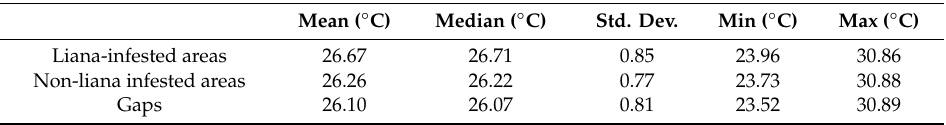
Table 1. Statistical characteristics of the canopy temperatures of the liana-infested areas, non-liana infested areas, and gaps, Max.: Maximum, Min.: Minimum, Std. dev.: Standard